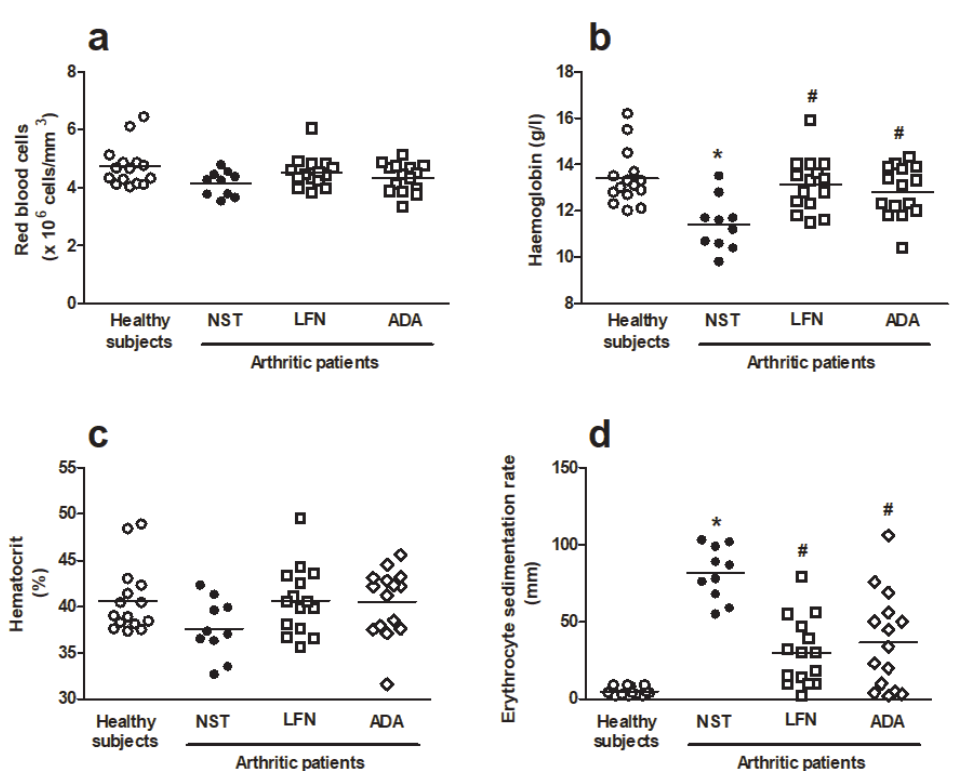
Figure 1 - Peripheral red blood cells ( a ), haemoglobin ( b ), hematocrit ( c ) levels and erythrocyte sedimentation rate ( d ) in patients with rheumatoid arthritis (RA) treated or not with either leflunomide (LFN; n =15) or adalimumab (ADA; n =15), in comparison with patients recently diagnosed with RA but not yet receiving specific treatment with anti-rheumatic drugs (NST group; n =10) and healthy subjects ( n =15). Data are expressed as mean and individual values obtained from each subject. Statistical differences between groups considered the mean + SD values of each group. * p <0.05, differs from healthy subjects; # p <0.05, differs from the NST